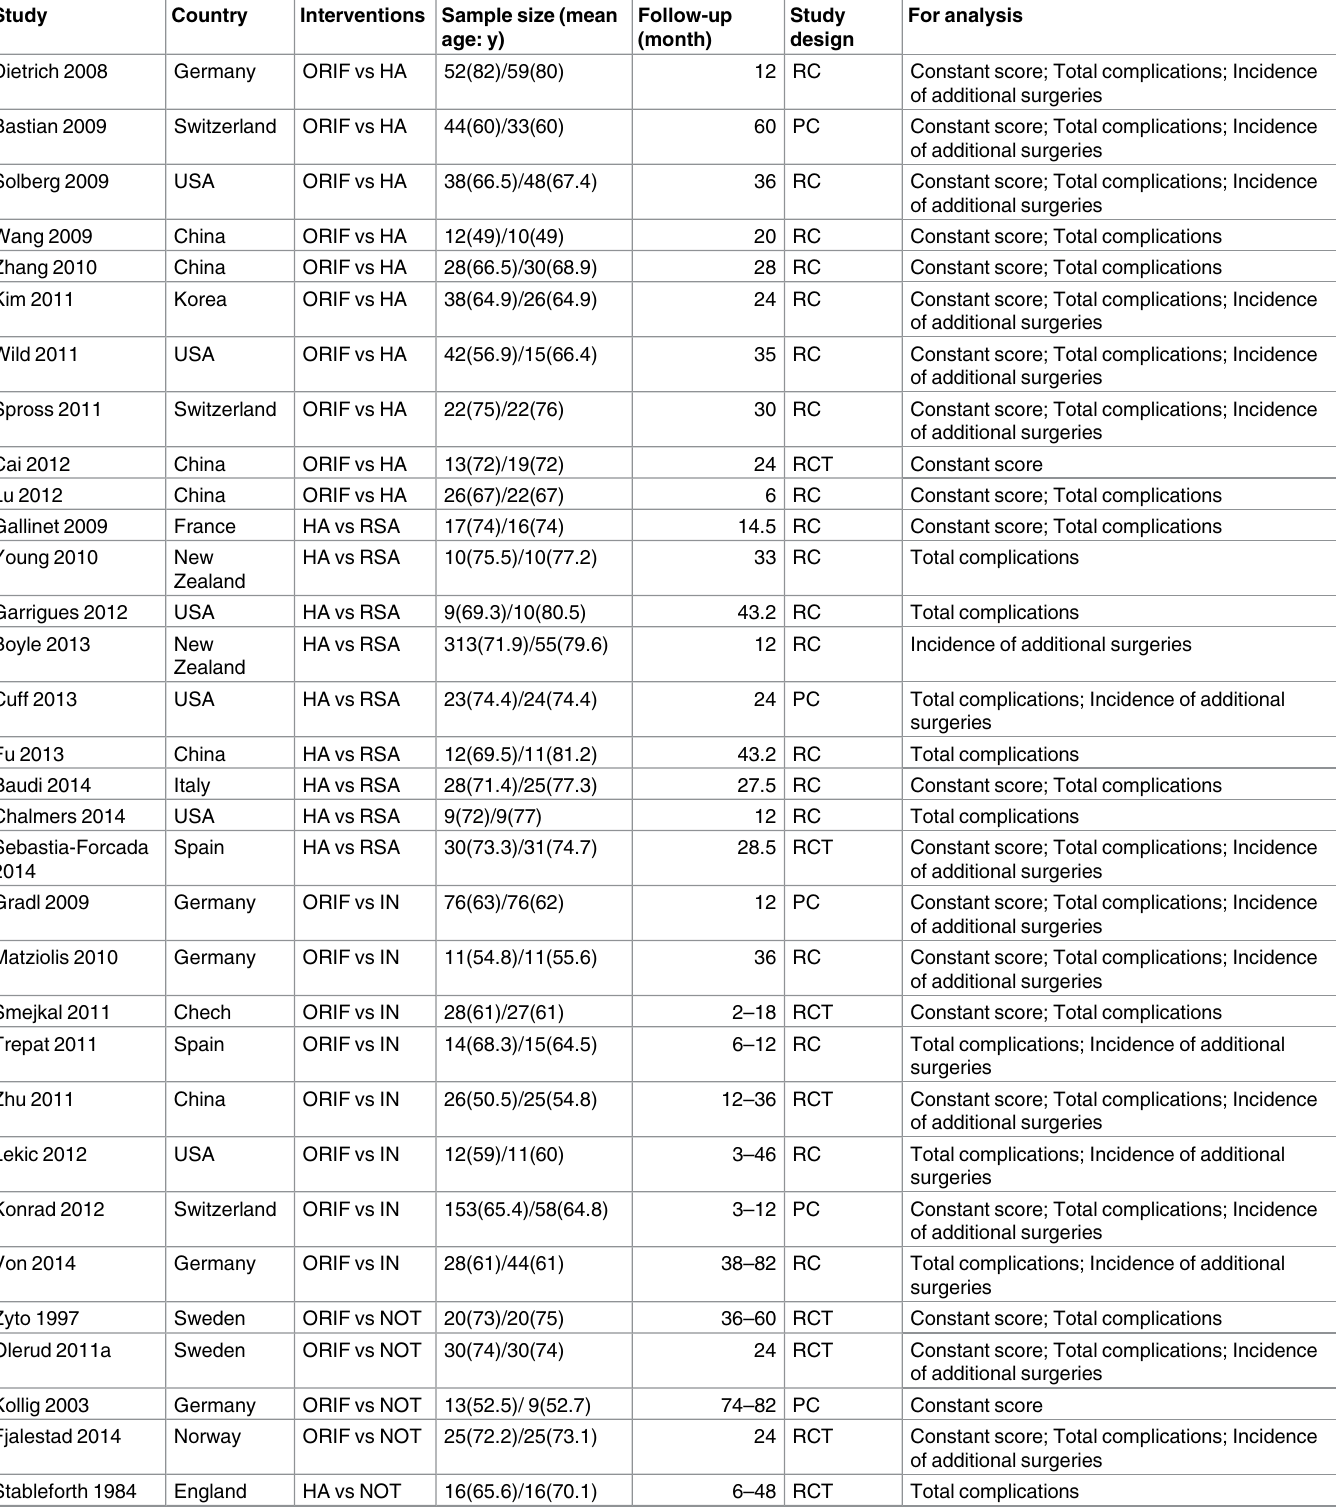
Table 1. Characteristics of Included Studies Comparing Different treatments for displaced proximal humeral